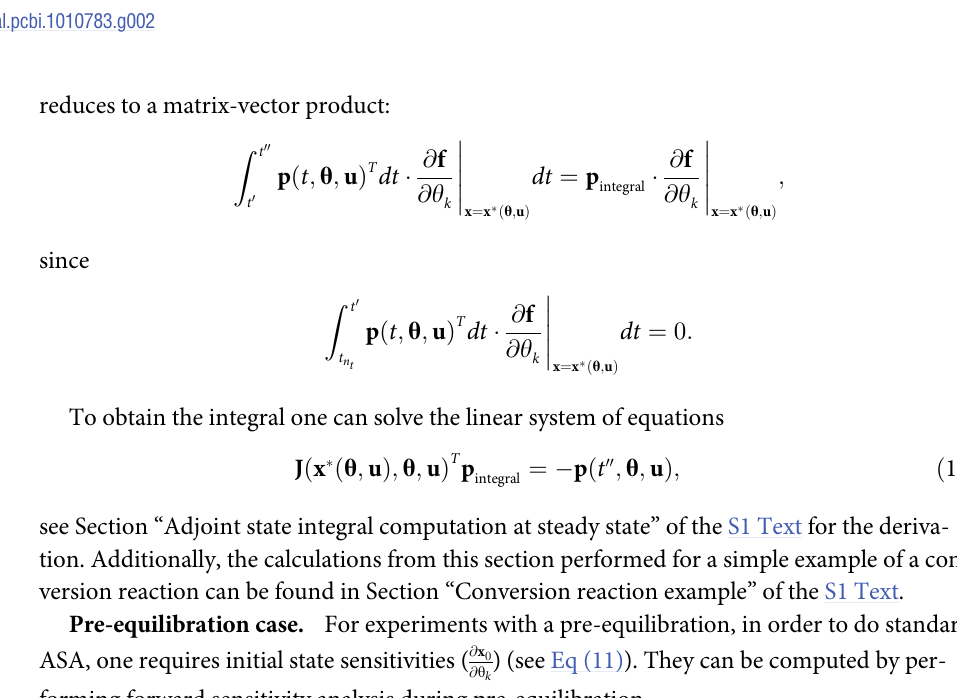
Fig 2. Computation of the adjoint state integral term. The top row illustrates the solution of the system (1) for (a) the post-equilibration case and (b) the pre-equilibration case for n t = 3. The bottom row illustrates the integral term in